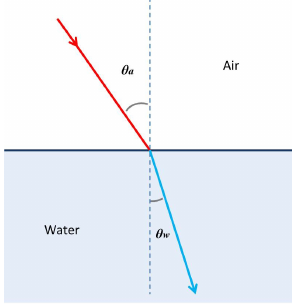
Figure 1. Refraction of light between air and water For a steep mountain channel, TLS measurement has been a challenge since mountain channels are generally complex landforms and the channel morphology consists of variety of units such as cascades, steps, pools and other type of channel unit where most of bed materials are relatively small